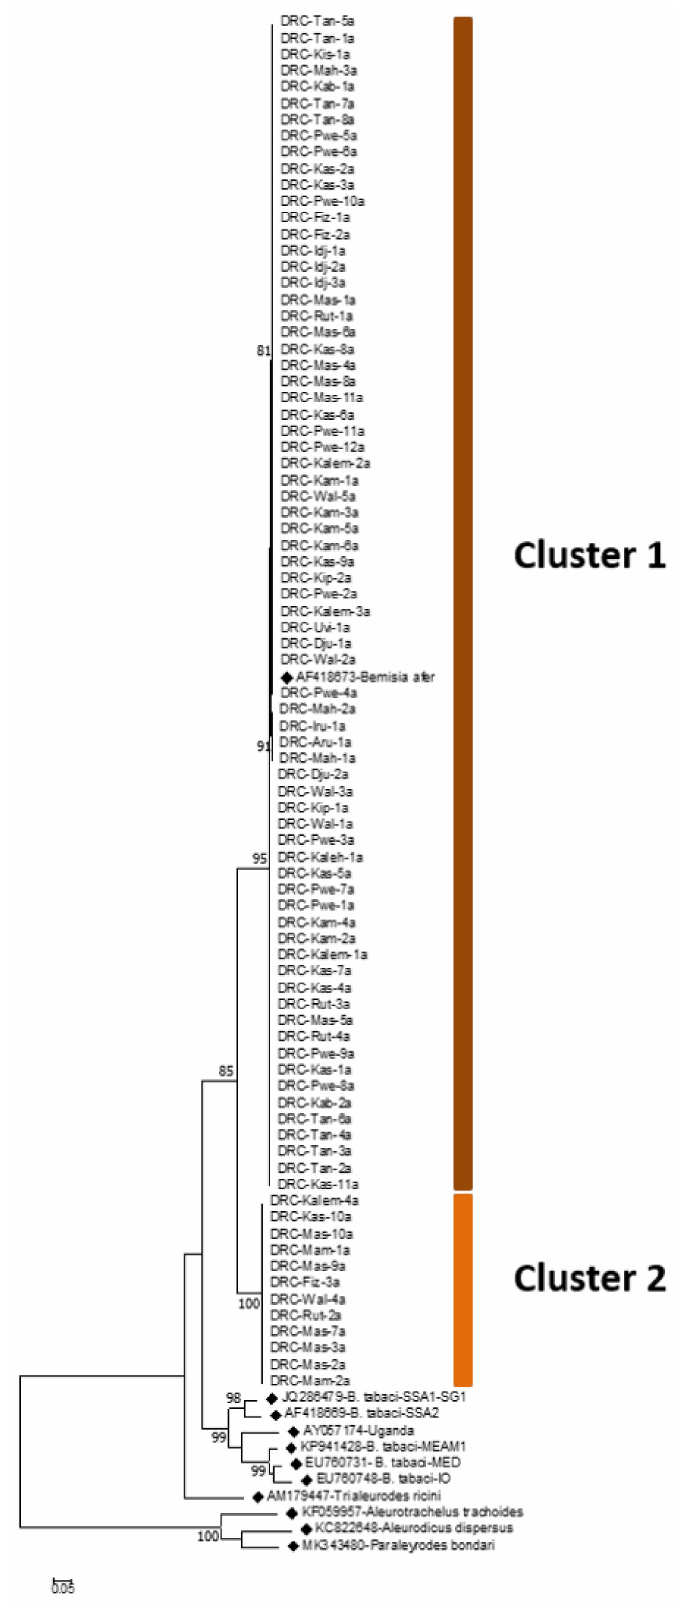
Figure 4. Maximum likelihood phylogenetic tree constructed for COI sequences obtained from Bemisia afer collected from eastern Congo between March 2016 and September 2018. Reference sequences from GenBank ( (cid:7) ) are included for